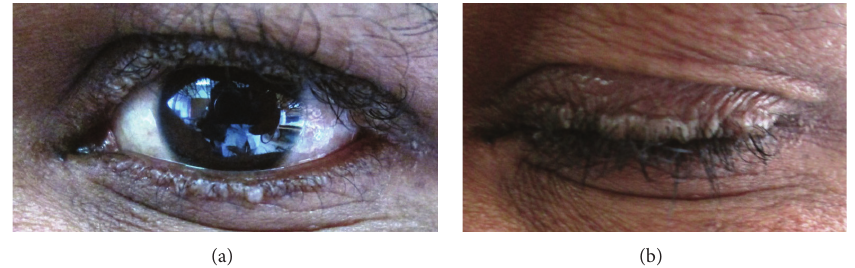
Figure 1: Waxy beaded papules on the margins of the eyelids.